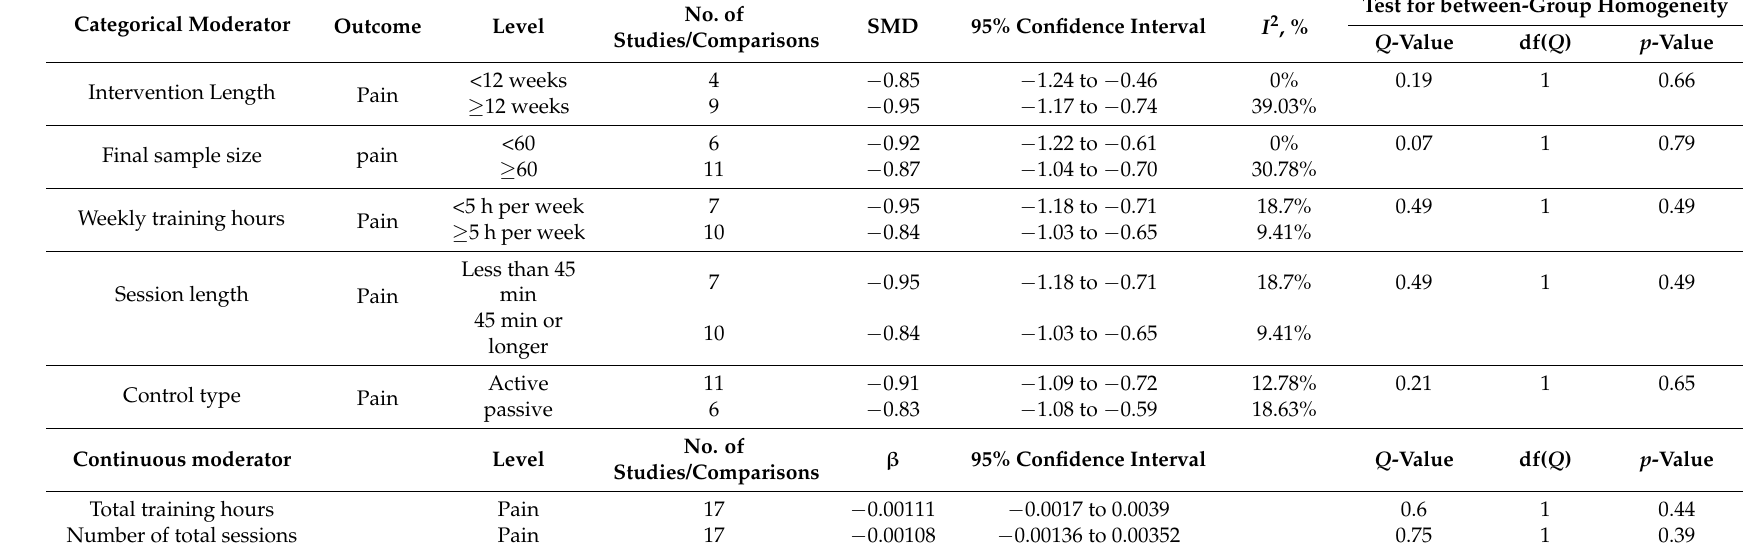
Table 3. Moderator analysis for Baduanjin versus control